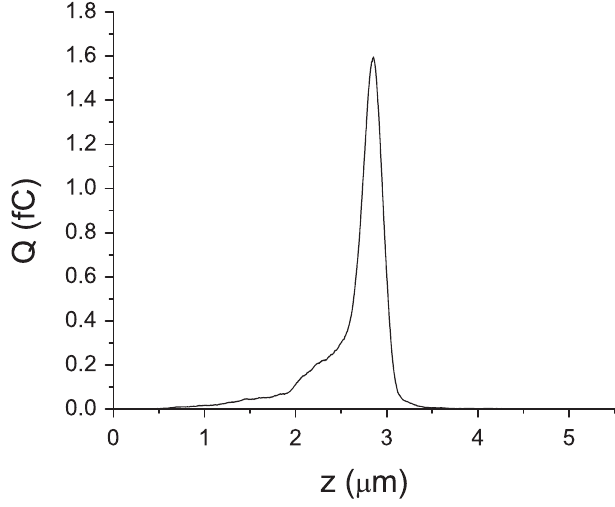
FIG. 4. Beam profile of the SPARX ultrashort beam as gen- erated with start-to-end simulations.